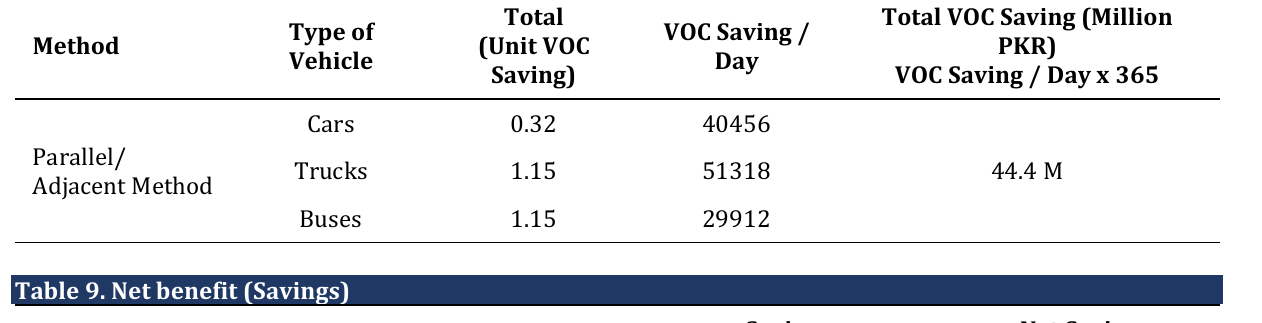
Table 9. Net benefit